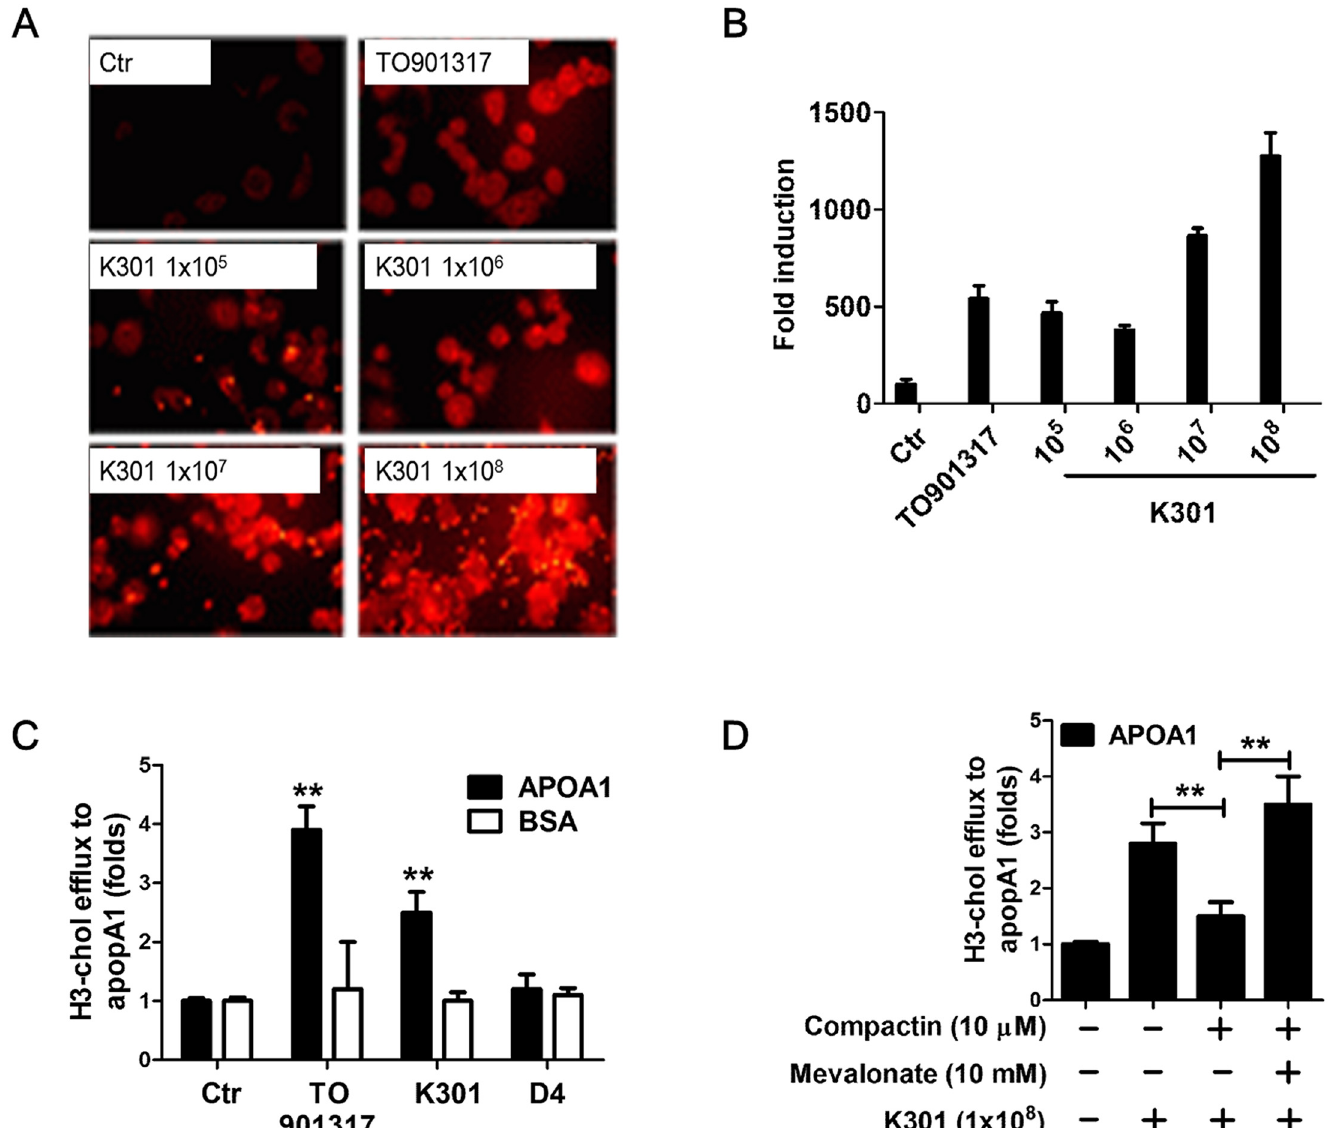
Fig 3. L . acidophilus K301 increased apoA-I mediated cholesterol efflux in macrophages. Cholesterol efflux from [H 3 ]-cholesterol (1 μ Ci/ml)-loaded macrophages to apoA-I (10 μ g/ml) was measured after incubation with heat-killed L . acidophilus K301 or TO901317. (A) The binding of Alexa-labeled apoA-I onto the surface of heat-killed L . acidophilus K301 treated-macrophages is shown. (B) Densitometry analysis was performed by ImageJ software after repeated experiments. The data shown is representative of two independent experiments. (C) Cholesterol efflux is expressed as the percentage of [H 3 ]- cholesterol in the media relative to total [H 3 ]-cholesterol (media and cells). An unpaired t-test was used to determine the significance of differences between treatment groups and control. (D) Cholesterol efflux was examined after stimulation with heat-killed L . acidophilus K301 in the presence or absence of compactin and mevalonate. Results are the means of three independent experiments (mean ± S.D). ** P < 0.01 vs. untreated cells. The error bars in individual samples are shown as variations from triplicate